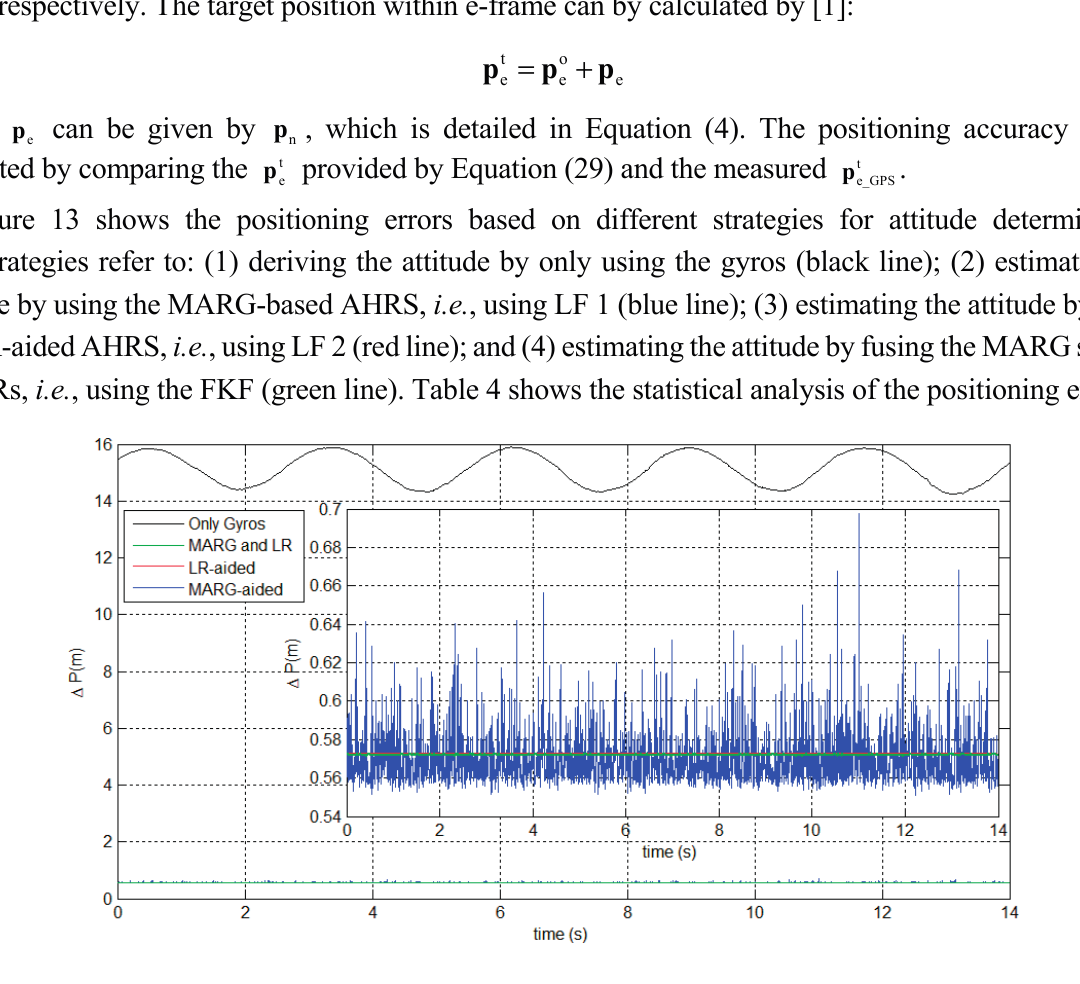
Figure 13. Target positioning errors based on the different